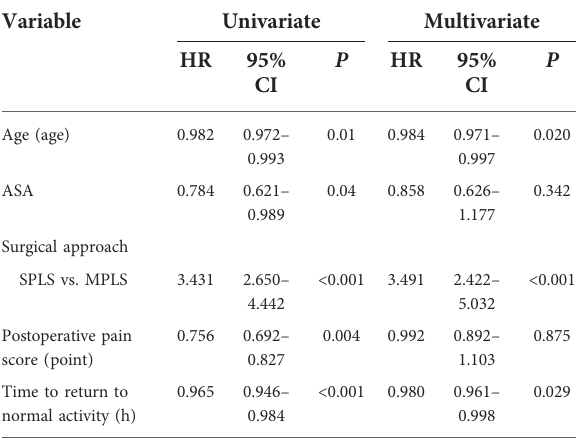
TABLE 3 Univariate and multivariate Cox proportional hazards analysis of postoperative time of RTW.